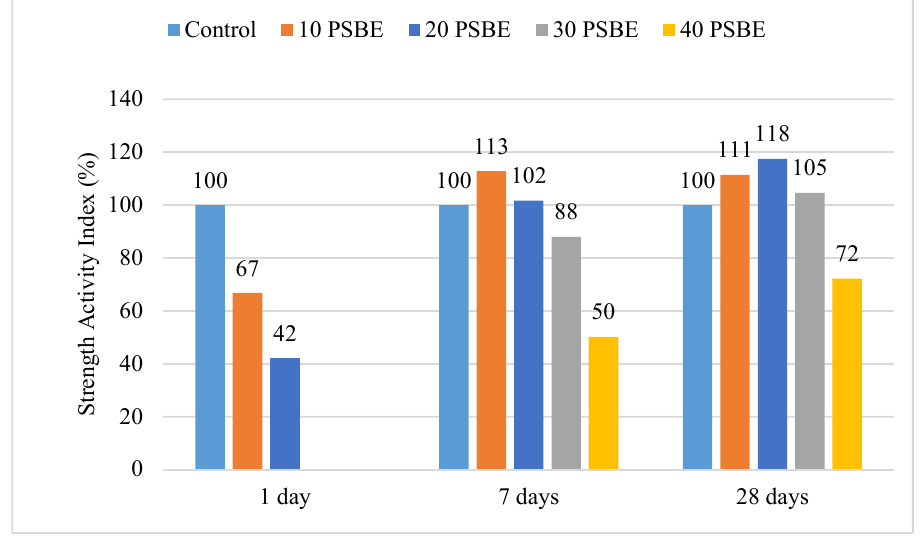
Figure 6. Compressive strength index of eggshell mortar.